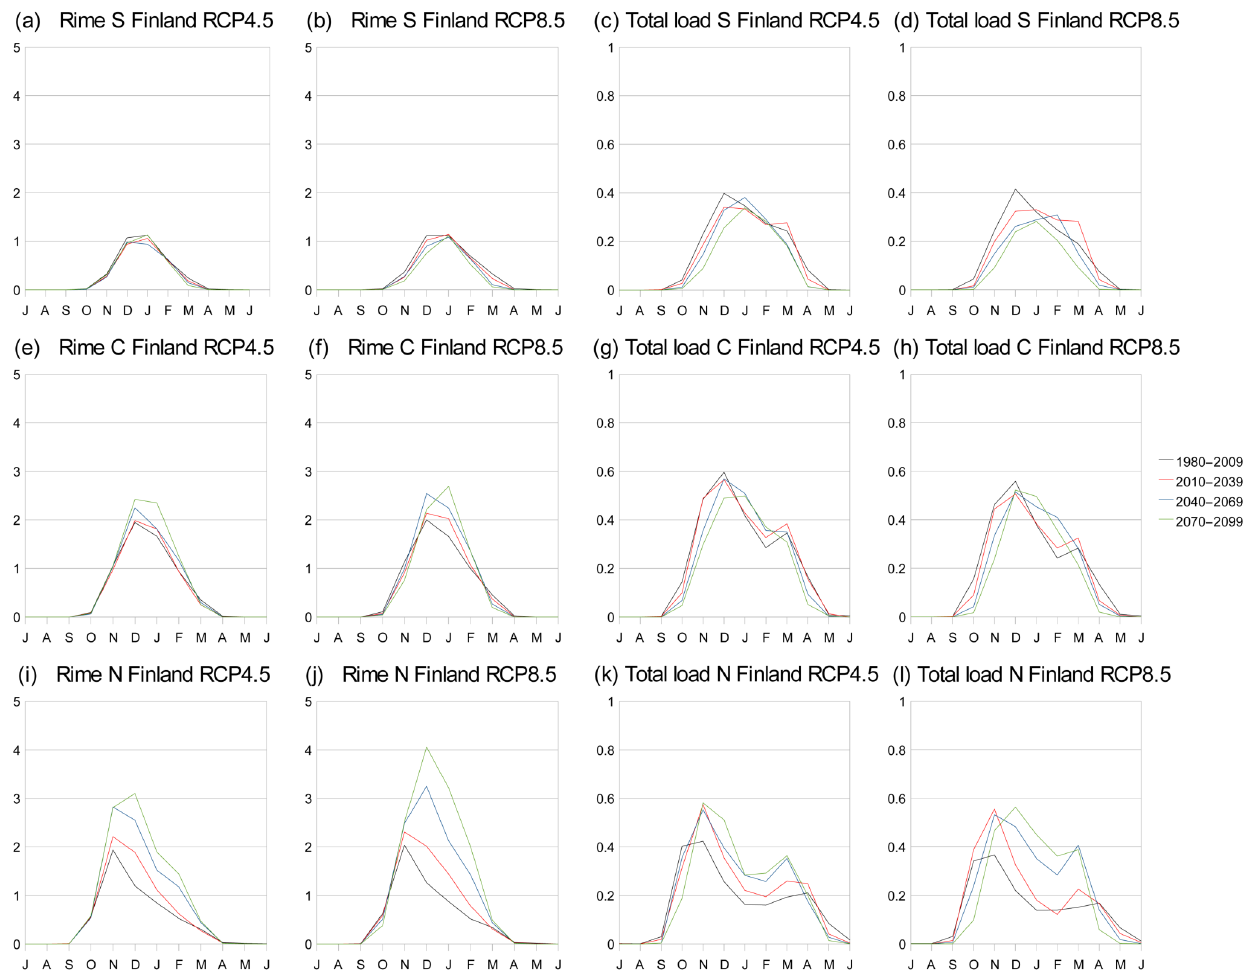
Figure 7. The annual numbers of risk days by month for heavy riming and heavy snow loading during 1980–2009 (black), 2010–2039 (red), 2040–2069 (blue) and 2070–2099 (green) under the RCP4.5 and RCP8.5 scenarios as averaged over southern (S; top row panels), central (C; middle row panels) and northern (N; bottom row panels)